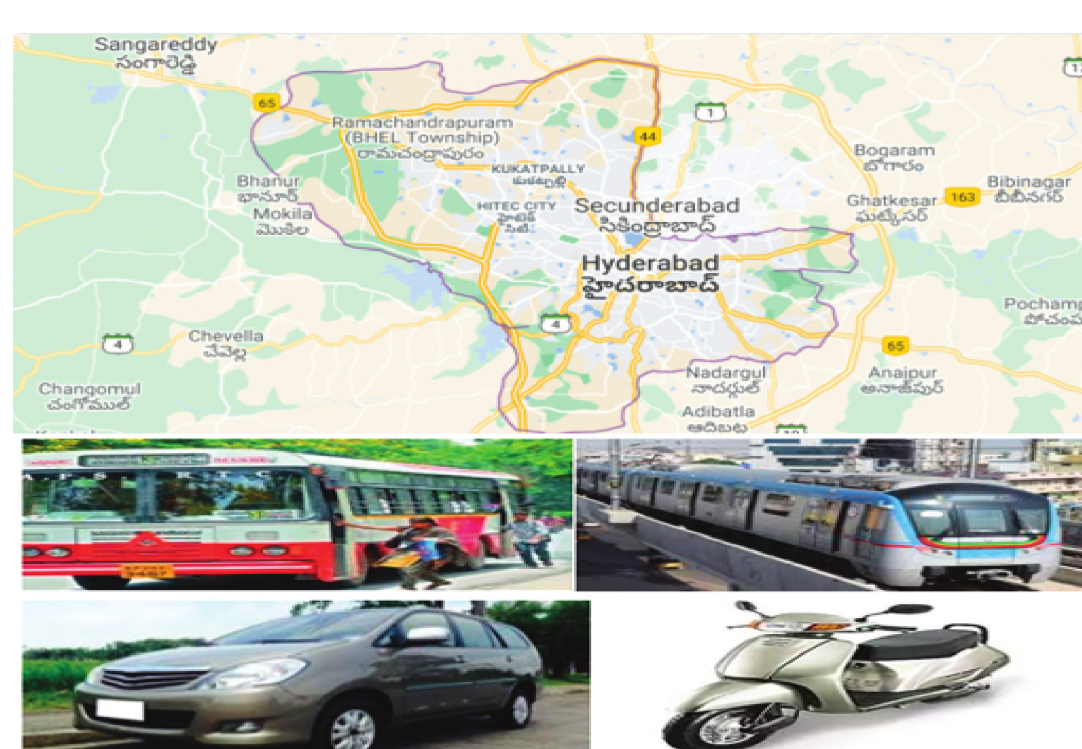
Figure 4: The proposed model.